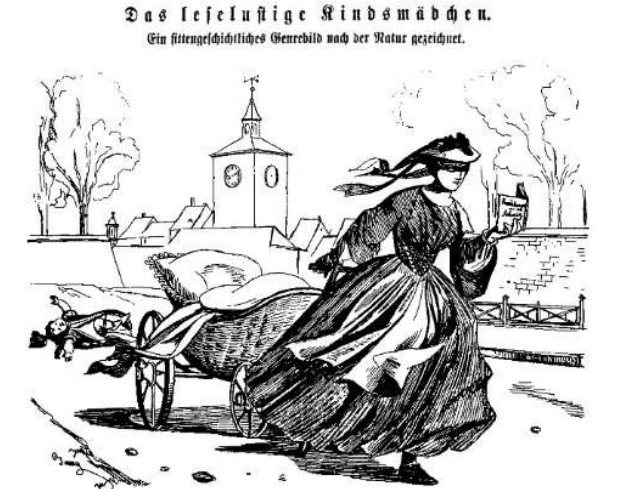
Figure 2 Book culture under the conditions of the mid to late 19 th century in Europe. A young “reading - impassioned” ( leselustige ) nanny ( Kindsmädchen ) rushes ahead with her reading, leaving her tiny charge crying in the street behind her. The subtit le reads: “an image of a particular type rendered according to the customs of the times.” (From the Deutsche Nationalbibliothek, Leipzig. Photo by author,